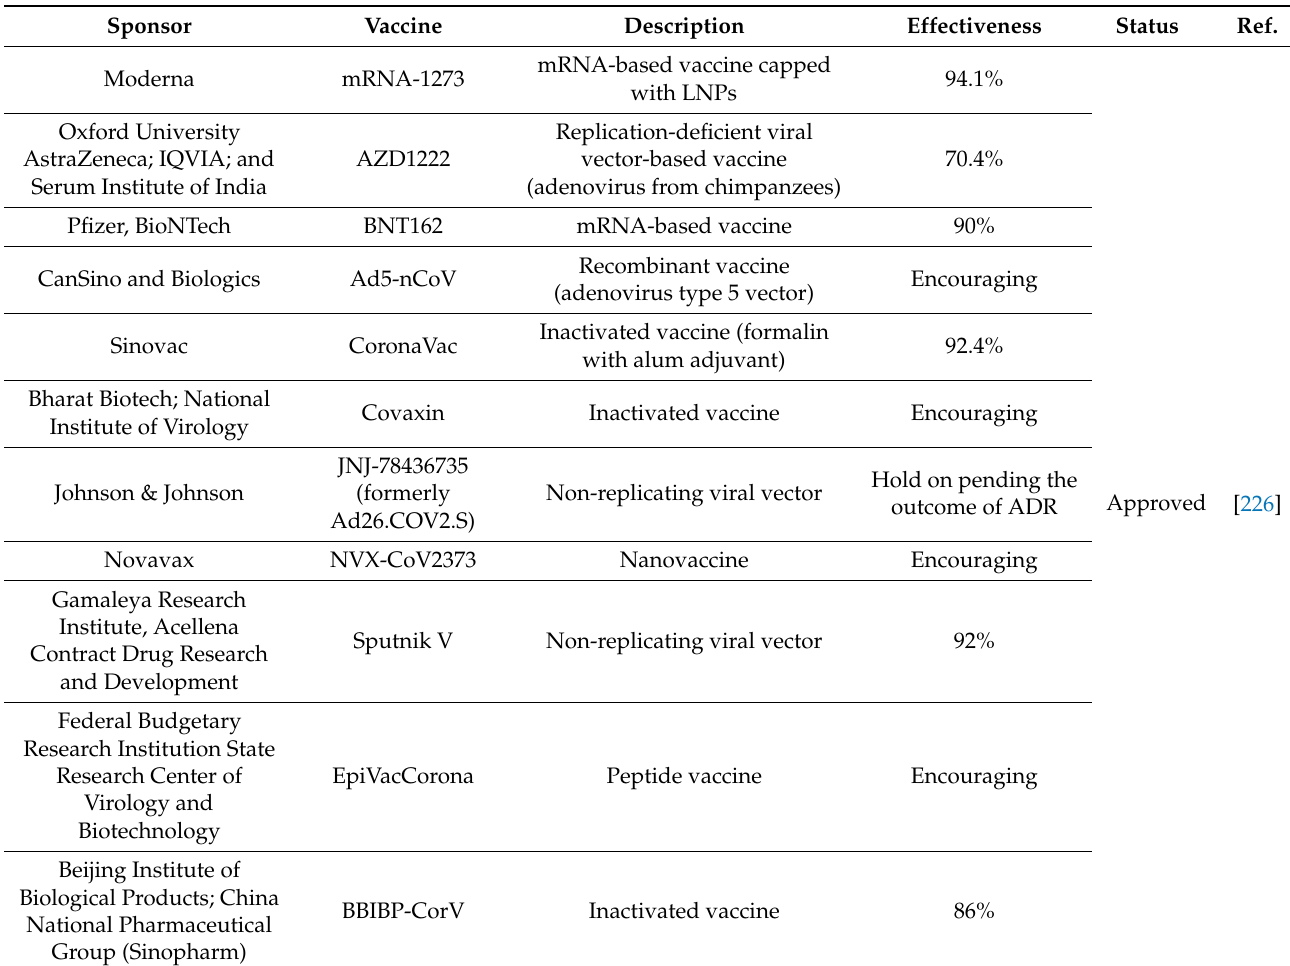
Table 4. Top successful COVID-19 vaccines approved and available for use outside of clinical trials. Sourced from the COVID-19 vaccine